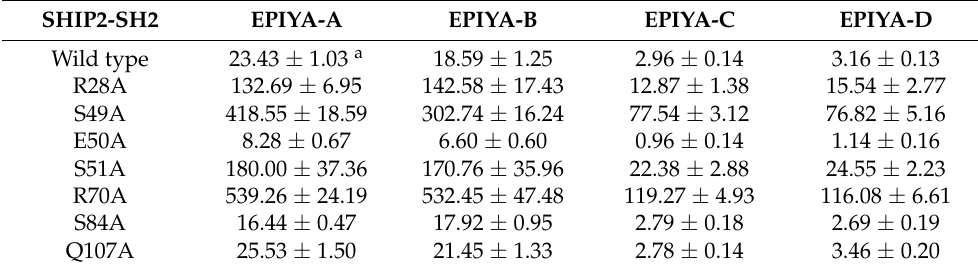
Figure 2. The binding interface and affinity of SHIP2-SH2 for CagA phosphopeptides from EPIYA-C and EPIYA-D motifs. ( A ) The chemical shift perturbation (CSP) of each residue during NMR titration with 8-mer and 13-mer CagA EPIYA-C and EPIYA-D phosphopeptides is shown with the threshold of 0.2 ppm for significant CSP, marked by the red line. ( B , C ) The residues with CSPs larger than 0.2 ppm or unassignable during the titration of 13-mer CagA EPIYA-C phosphopeptide are mapped onto ribbon representation ( B ) and molecular surface representation ( C ) of SHIP2-SH2 structure (PDB ID: 2MK2). Secondary elements are labeled in red font ( B ), and the pY-pocket is indicated by a red dashed circle ( C ). ( D ) Binding affinities of 8-mer EPIYA-CD, 13-mer EPIYA-C and 13-mer EPIYA-D phosphopeptides for SHIP2-SH2 revealed by fluorescence polarization (FP) assay. The fitted dissociation constants ( K D , µ M) are indicated as inset, respectively. ( E ) Key residues of SHIP2-SH2 for binding to 13-mer EPIYA-C and 13-mer EPIYA-D phosphopeptides revealed by mutagenesis and FP assay. The determined K D values are shown in Table 1. Table 1. The dissociation constants ( K D , µ M) of wild-type (WT) and seven mutants of SHIP2-SH2 for four types of 13-mer EPIYA peptides determined by fluorescence polarization